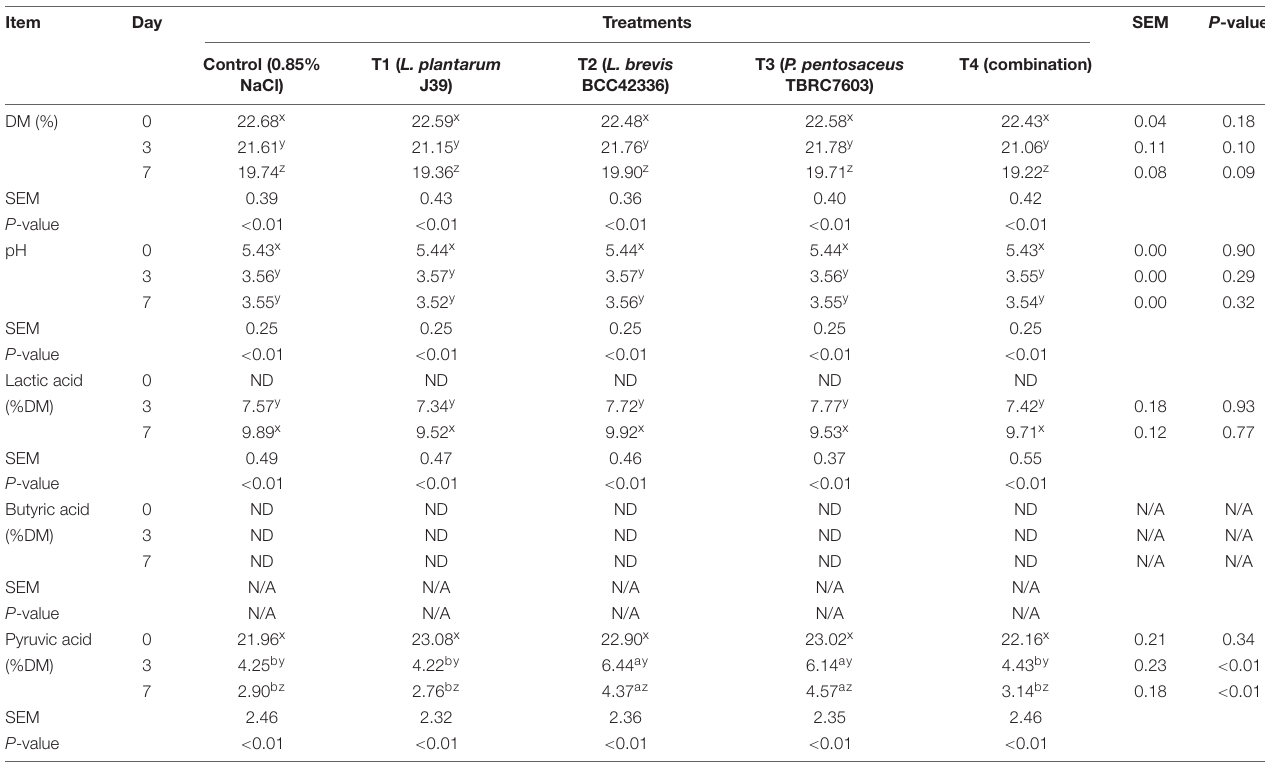
TABLE 2 | Fermentation quality of whole-plant corn silage during the ensiling process. Item Treatments SEM P